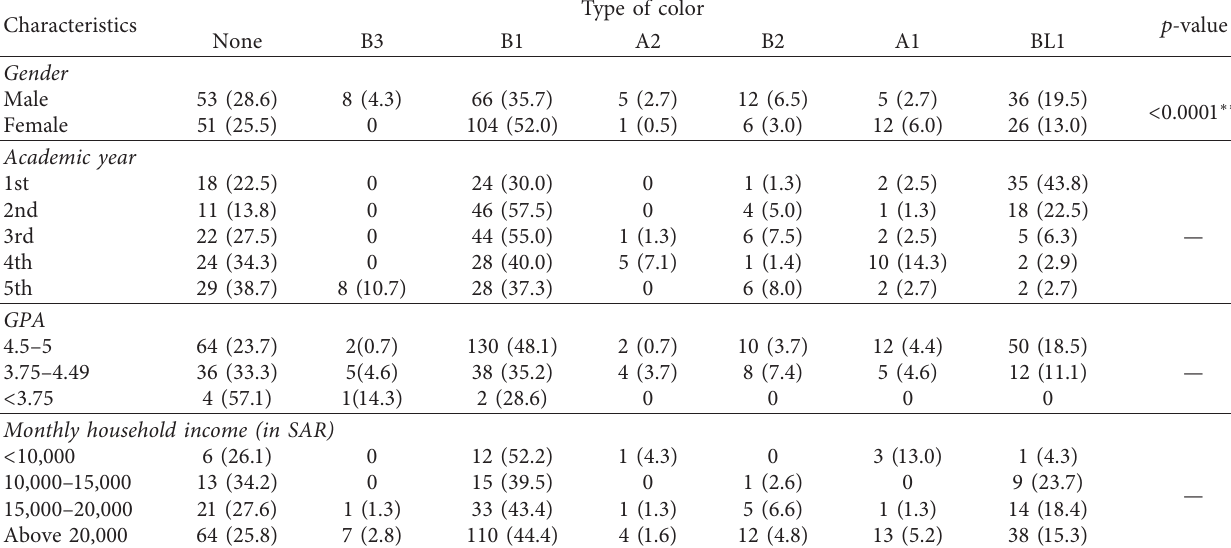
Table 5: Comparison of the subjects’ responses regarding shade preference for teeth with respect to their characteristics.